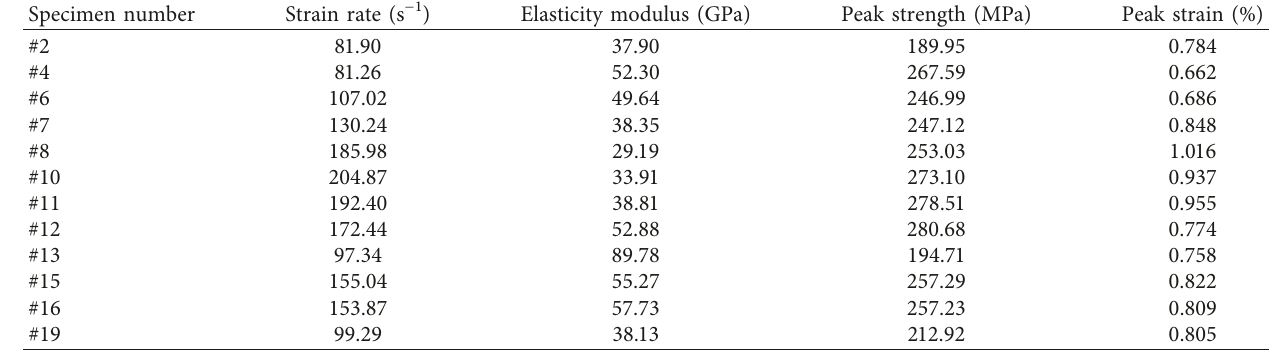
Table 1: Test result of the granite under impact load.